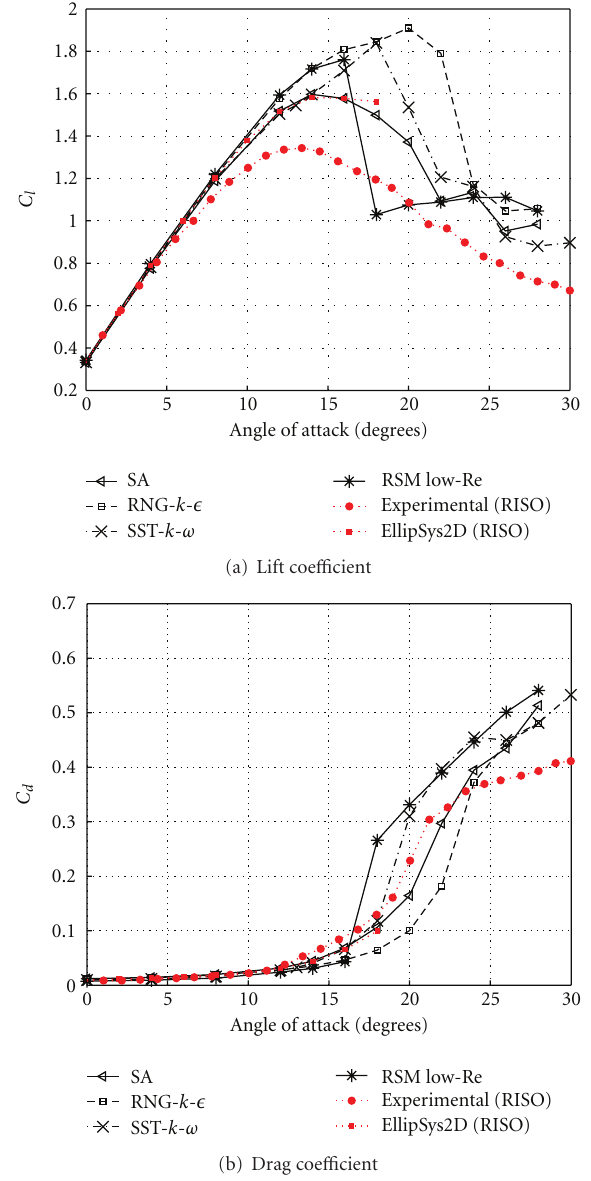
Figure 4: Lift and drag coe ffi